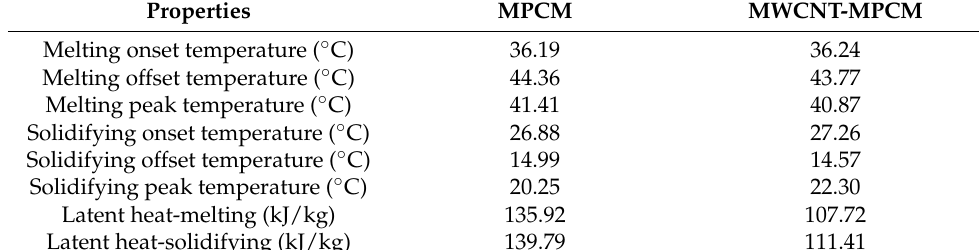
Table 1. DSC data of MPCM and MWCNT-MPCM.